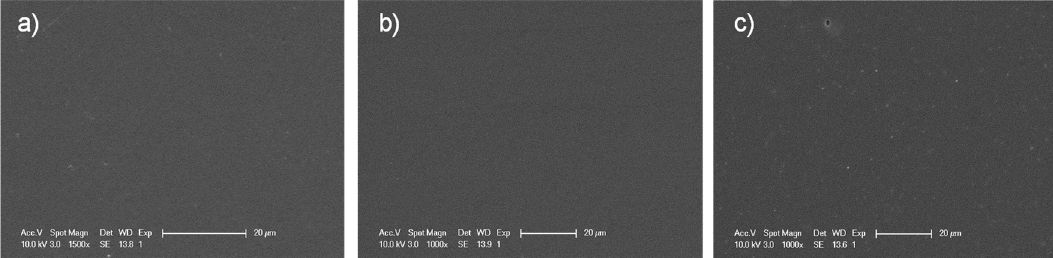
Figure 2. SEM images of the films containing the copolymers: ( a ) P(AN 0.6 - co -MTA1 0.4 -Bu), ( b ) P(AN 0.6 - co -MTA4 0.4 -Bu) and ( c ) P(AN 0.6 - co -MTA6 0.4 -Bu).